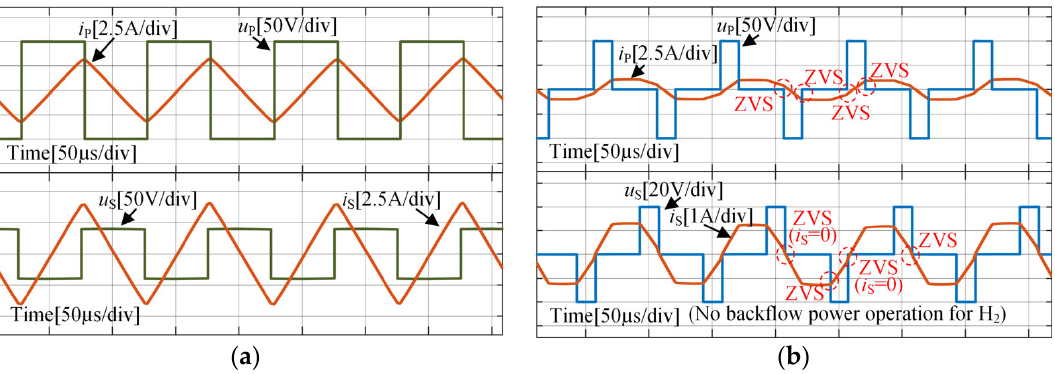
Figure 11. Steady ‐ state waveforms with two control methods in LCL resonant tank when U in = 20 V Figure 11. Steady-state waveforms with two control methods in LCL resonant tank when U in = 20 V and k = 0.4. ( a ) SPS modulation; ( b ) Soft ‐ switching and no backflow power control. and k = 0.4. ( a ) SPS modulation; ( b ) Soft-switching and no backflow power